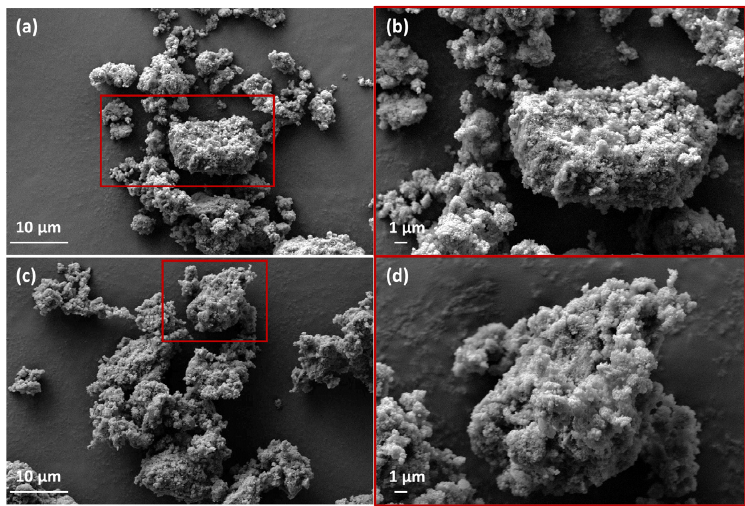
Figure 6. SEM micrographs at different magnifications for the prepared geopolymers, GP ( a , b ) and GPAO ( c , d ).